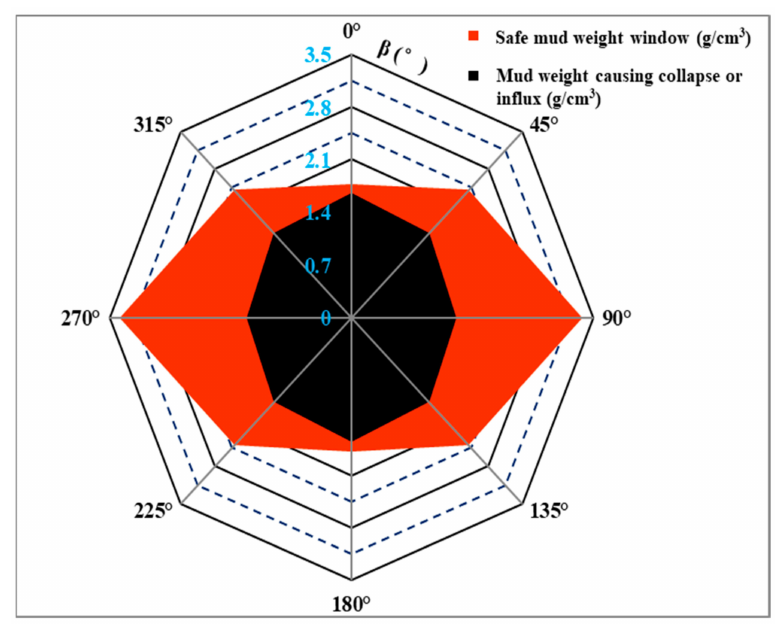
Figure 6. Safe mud weight window of the target zone with ∆ p p / p p = 0.2.